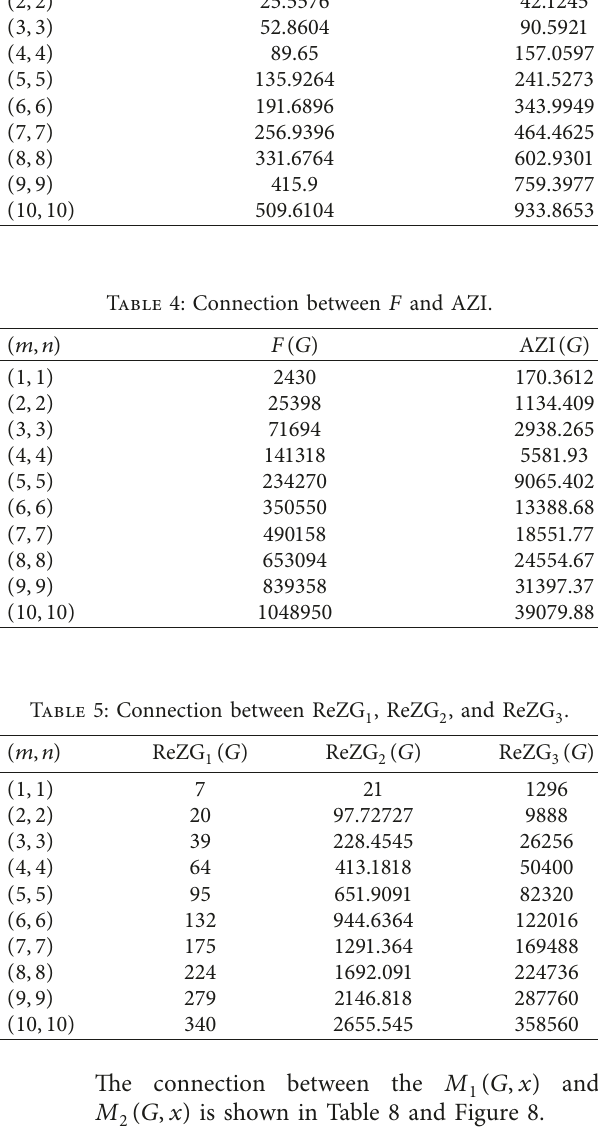
Table 7: Connection between M